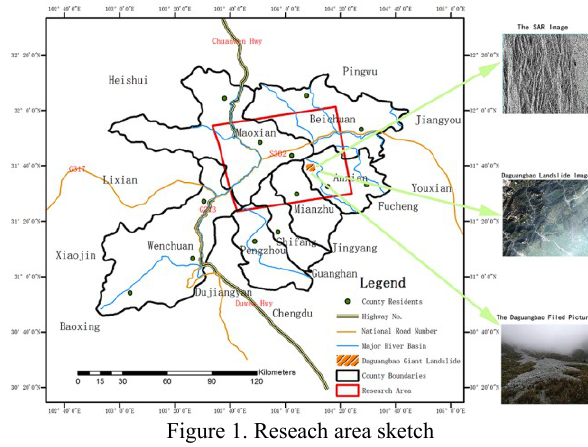
Figure 1. Reseach area sketch